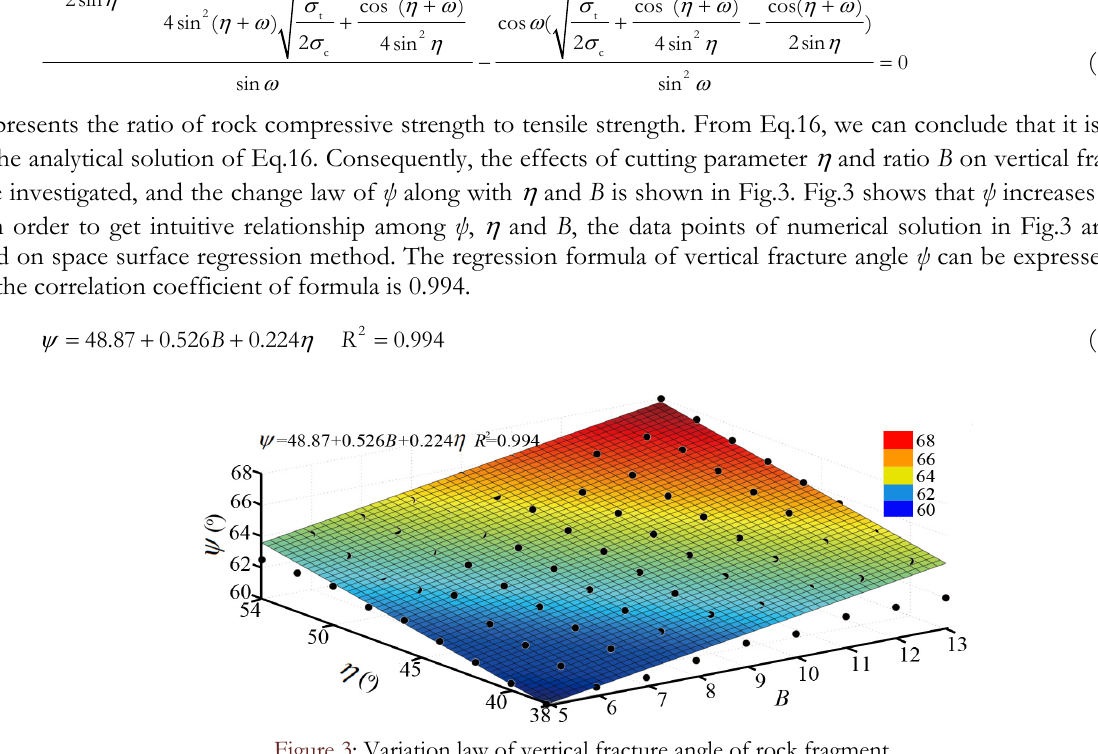
Figure 3: Variation law of vertical fracture angle of rock